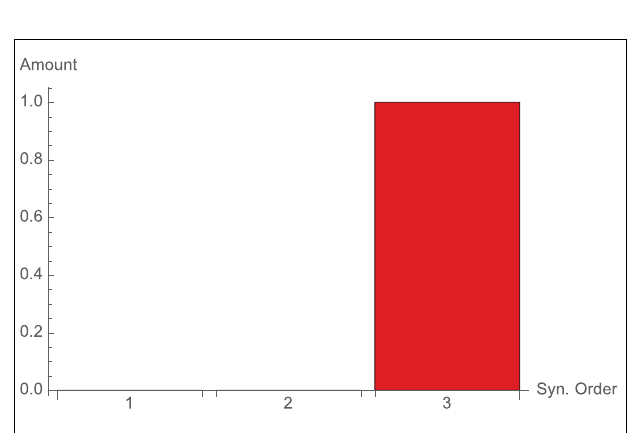
FIGURE 7 | Synergies of different orders for the three wise parity function, Example 3.4 .